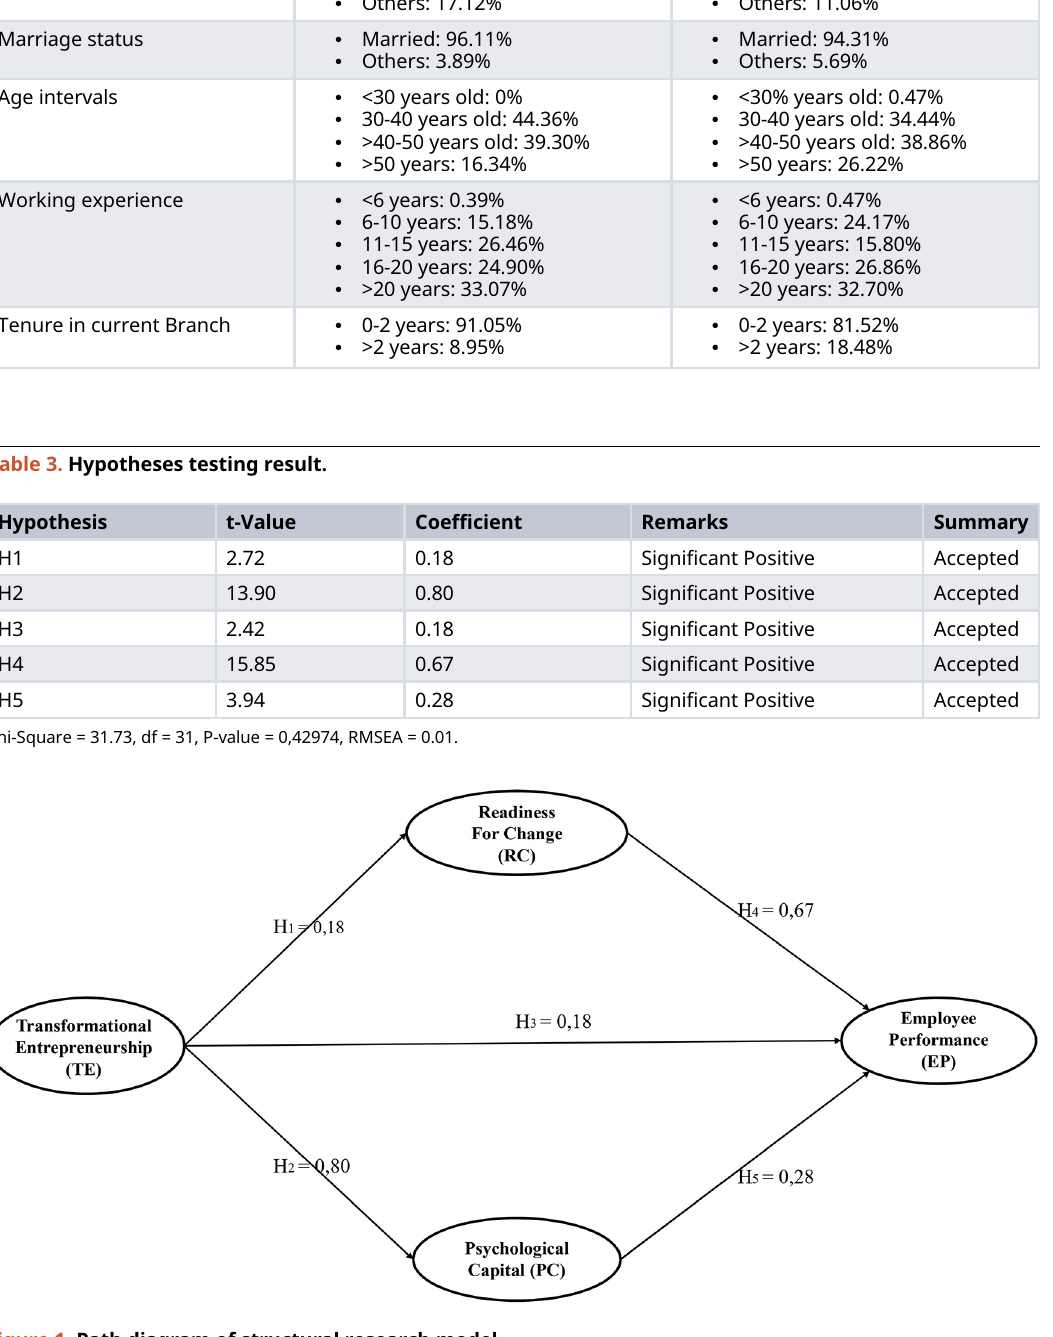
Figure 1. Path diagram of structural research model.